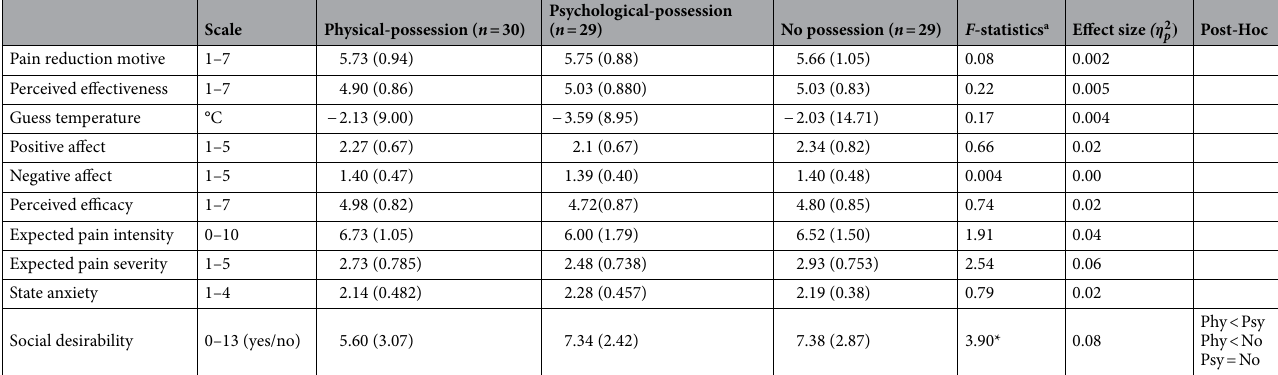
Table 2. The means, standard deviations (in parentheses), and F-statistics of psychological-state variables as a function of possession condition. Values outside parentheses are means, inside are standard deviations. Phy physical possession, Psy psychological possession, No no possession. *p < 0.05. a For univariate F -tests, degrees of freedom are (2,